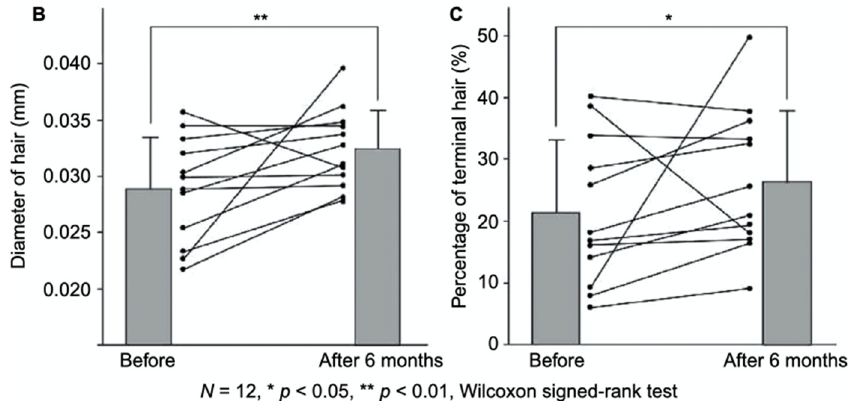
Figure 3. Promotion of hair growth by FGF-2-containing heparin–protamine nanoparticles. ( a ) Rep- resentative photographs of improved cases after 6 months of treatment. Increases in ( b ) the hair diameter and ( c ) the percentage of terminal hair. Adapted from ref. [56].